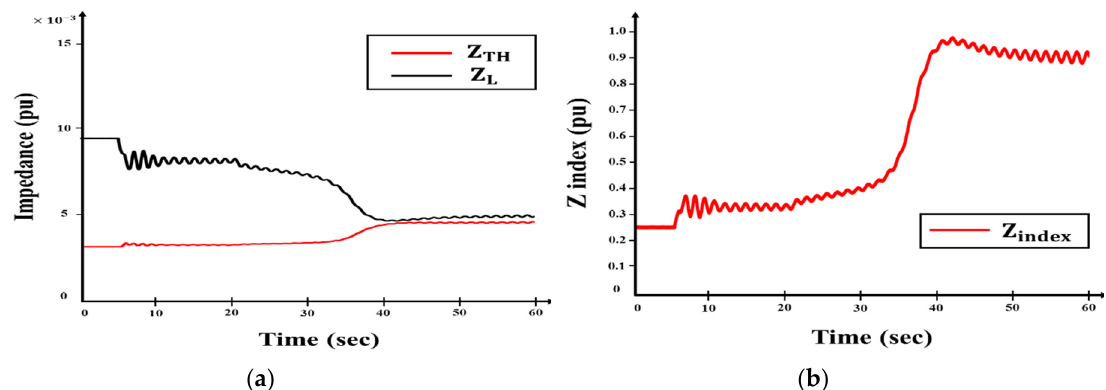
Figure 14. Progress of the index in case 1. ( a ) Z Th and Z L . ( b ) Z index.